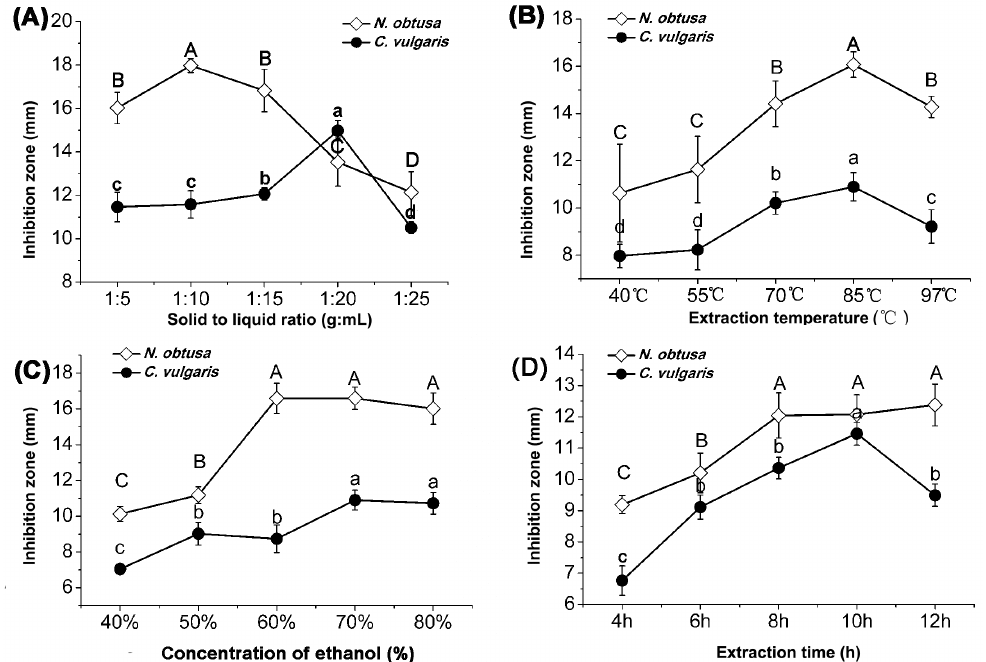
Fig. 2: Effect of solid to liquid ratio (A), extraction temperature (B), ethanol concentration (C), and extraction time (D) on antimicrobial activities in extracts from N. obtusa and C. vulgaris against S.aureus . Different letters indicated significant differences (p<0.05; one-way analysis of variance (ANOVA) and Duncan’s multiple range test). Bars represent the means ± standard deviation. Each was replicated nine